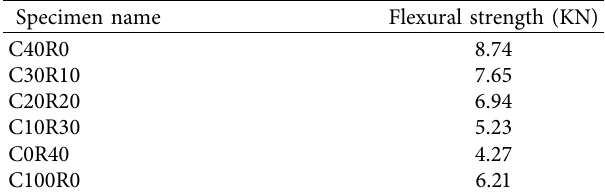
Table 11: Load-displacement diagram.